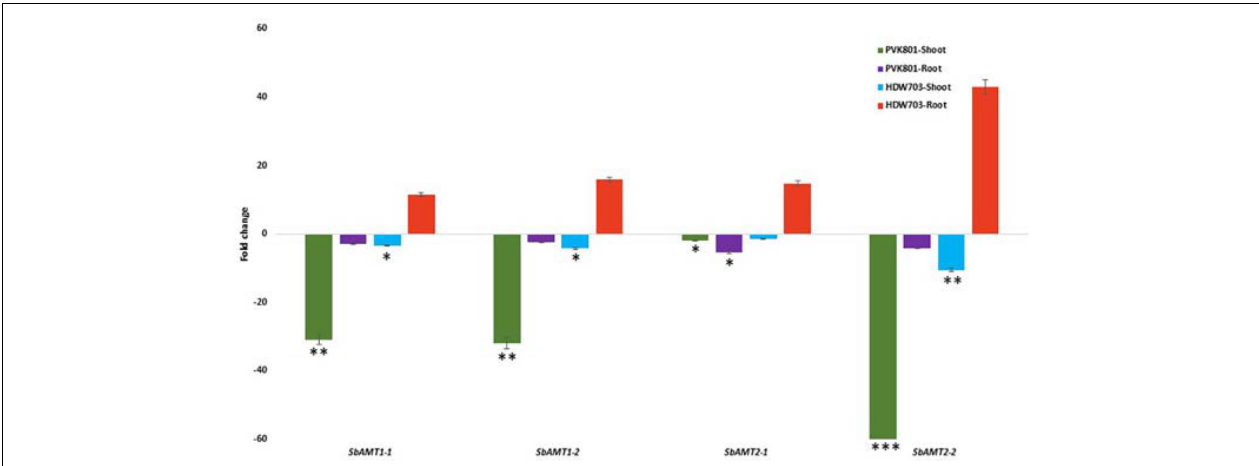
FIGURE 5 | Expression profiles of SbAMT genes in shoot and root samples of high (PVK801) and low NUE (HDW703) genotypes, under N0 condition. Here N0 condition taken as treated and N100 used as control. *, **, and *** denotes significance at 5, 1, and 0.1% P, remaining not significant.